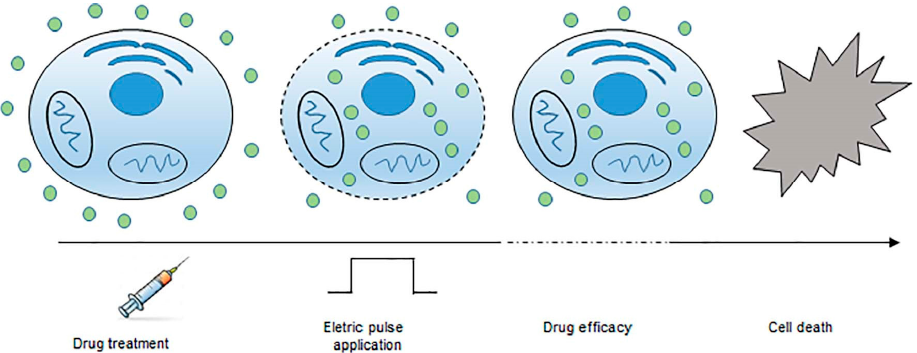
Figure 3. Principle of electrochemotherapy. After drug injection and application of intense and short electrical pulses, the cell membrane becomes more permeable. Most drug molecules enter the cells inducing cell death.